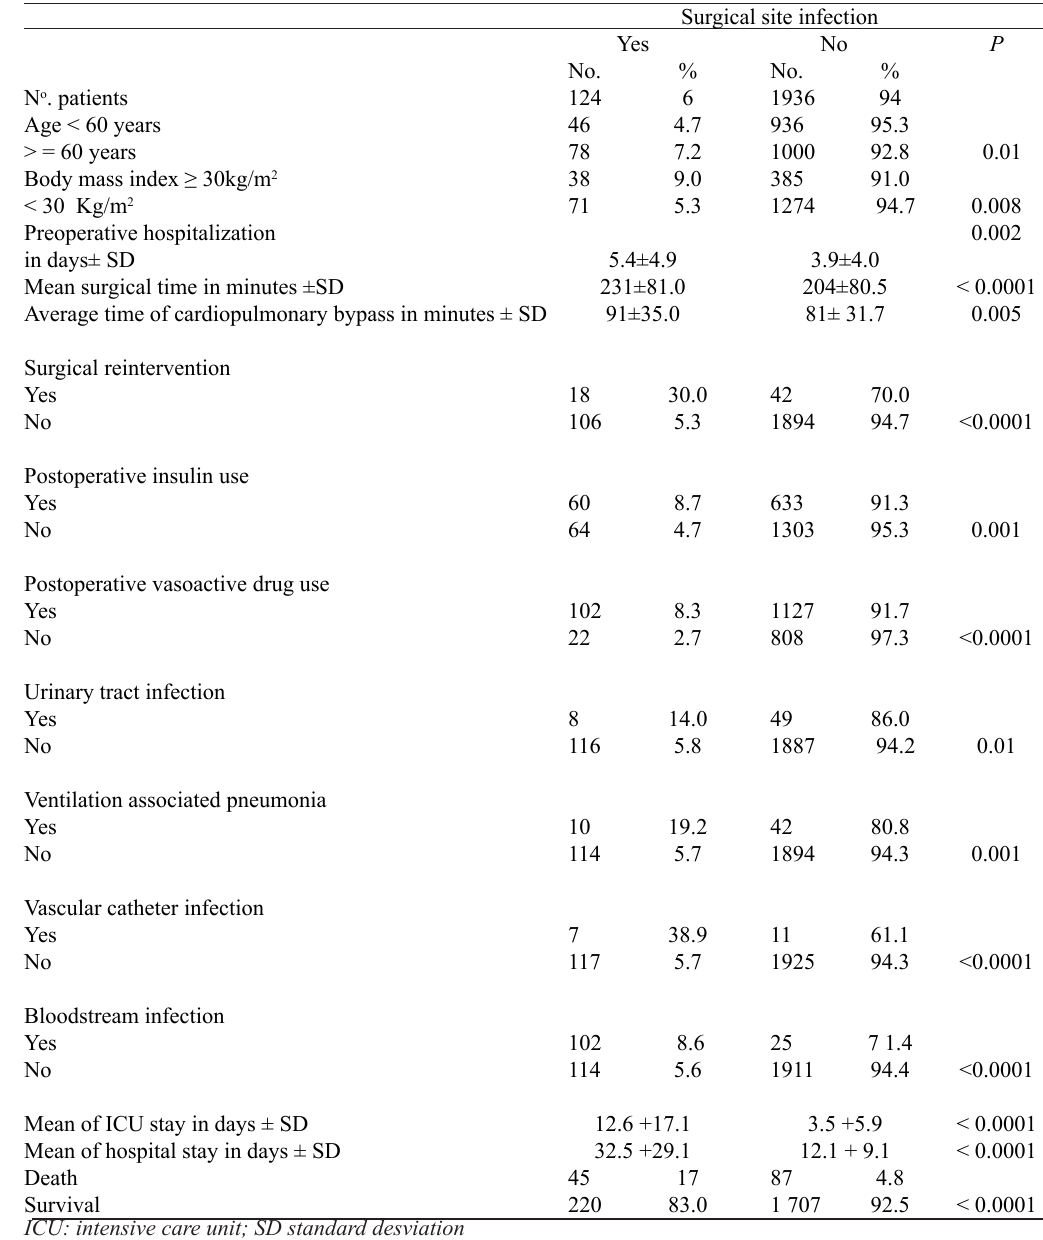
Table 4. Variables associated with the occurrence of surgical site infection (SSI).